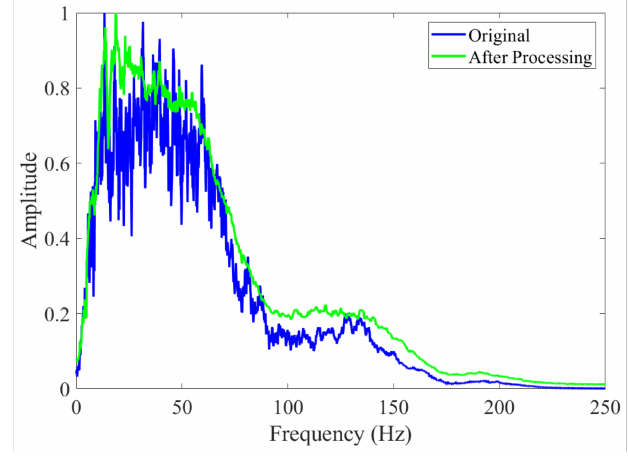
Figure 19. Spectrum comparison before and after